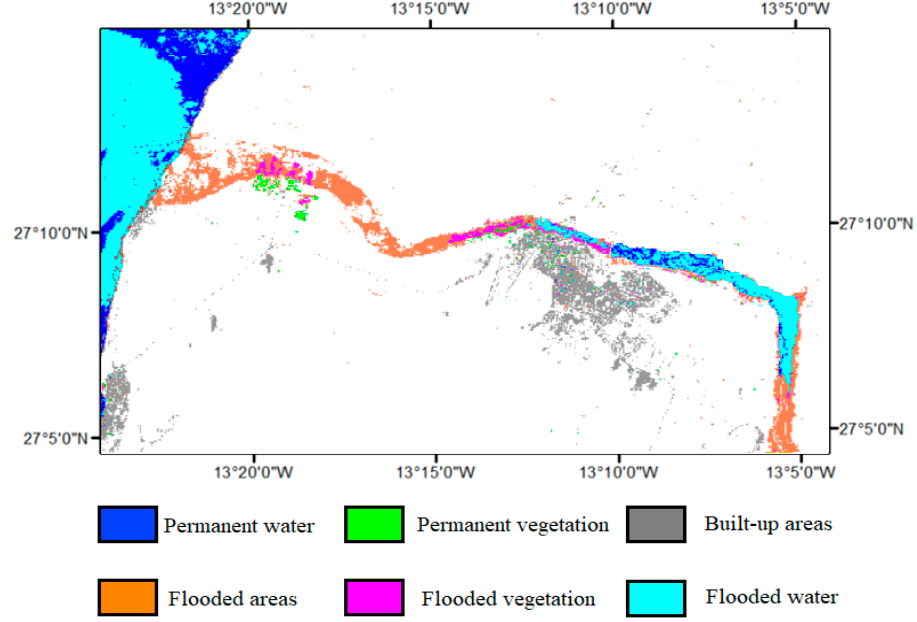
Figure 17. Decision tree classifier’s post-classification change detection model results using both dates SVM’s resultant maps (20 and 30 October 2016).